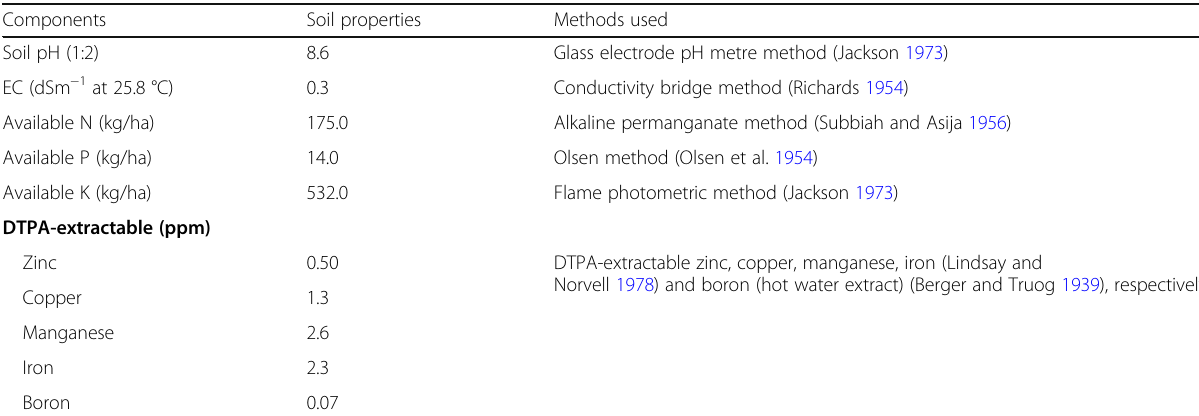
Table 1 Mechanical and chemical analysis of the experimental soil